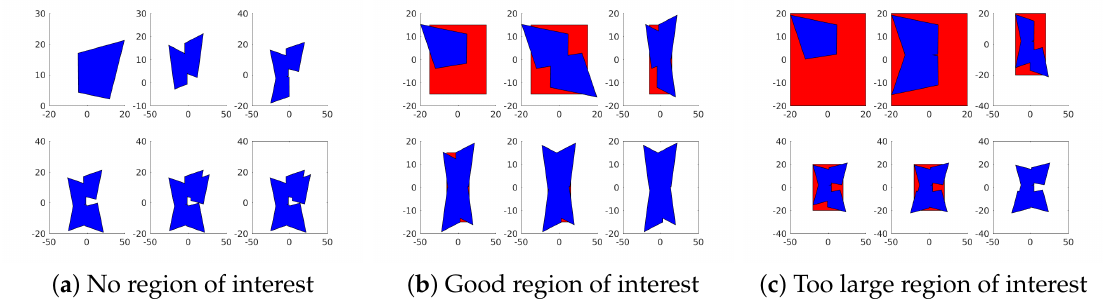
Figure 5. The placement of cameras in the array following the greedy algorithm for various regions of interest. Blue shapes are the total coverage of cameras in the array, and red indicates the region of interest used. The plot in the lower right of each figure shows the resulting field of view without the region of